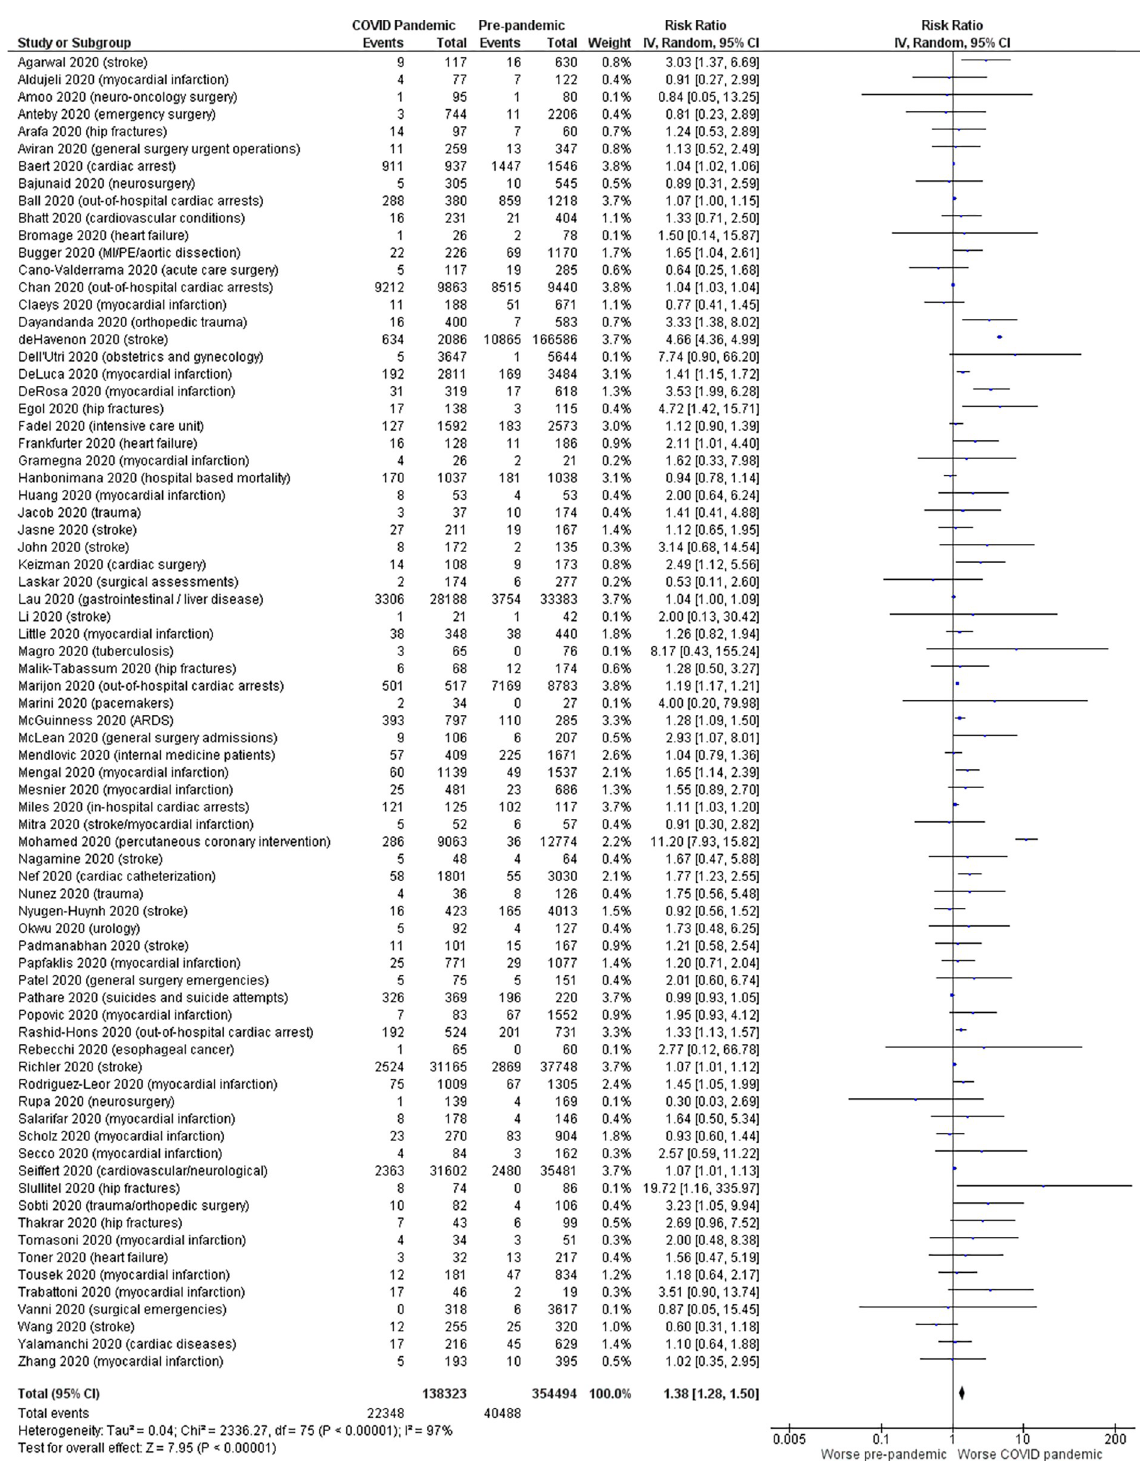
Fig 2. Forest plot for overall mortality (meta-analysis).